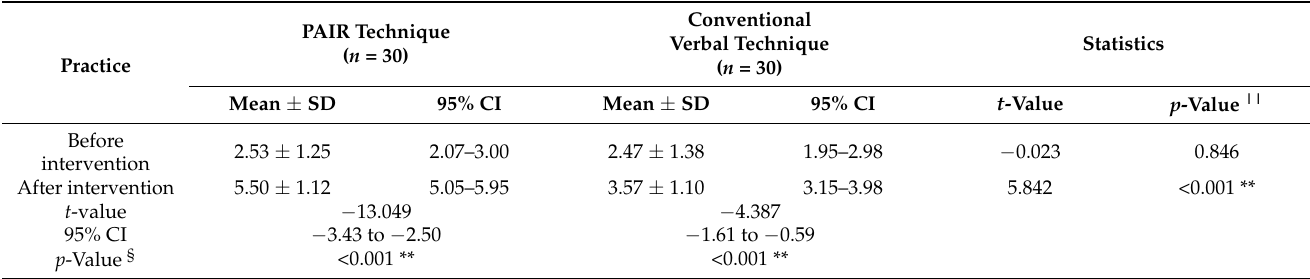
Table 4. Comparison of oral hygiene practice score in the study population of PAIR technique and conventional technique before and after the